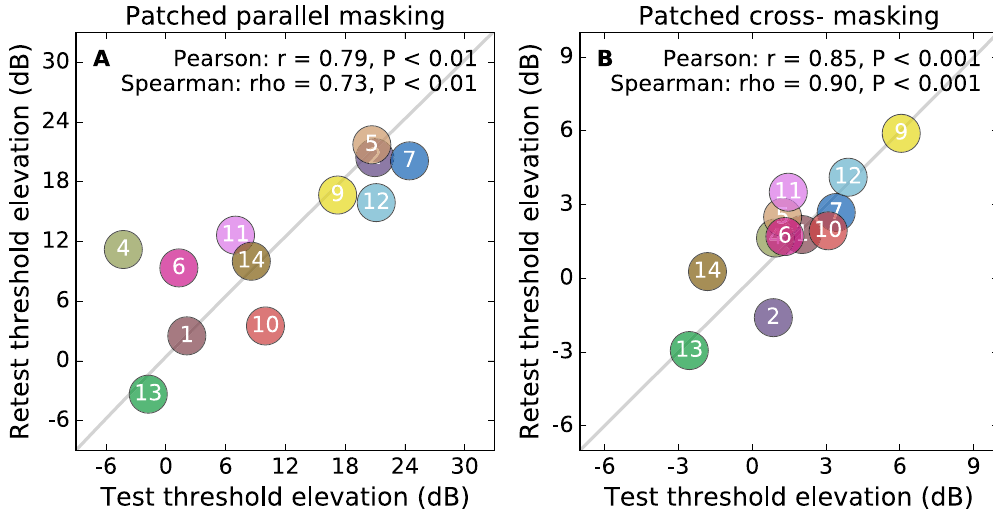
Figure 3. Test-retest reliability of the masked thresholds following patching. Panel A shows the correlation between the threshold elevation (relative to the baseline threshold) introduced by the parallel mask in the first and second testing sessions. Panel B shows the correlation between the measurements from the two sessions for the cross-oriented mask. Subjects 3 and 8 are omitted from this figure as they each repeated the experiment three times rather than